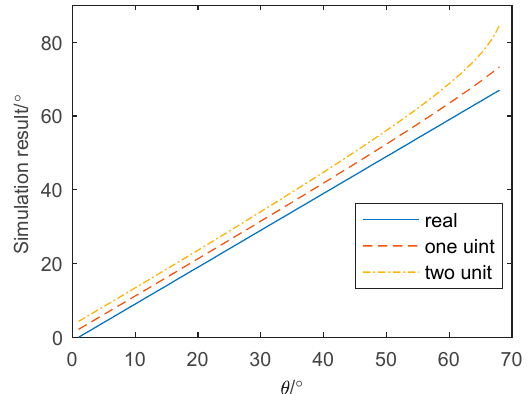
Figure 8. The 2-D imaging result of rang-elevation. It can be seen that the scatterers P 1 , P 2 and P 3 can be reconstructed accurately, but there is some error between the simulation result and actual position of the scatterer P 4 . The bandwidth of signal decides the range resolution. The range result of some scatterers may shift one range unit, thus the maximum error in range dimension by proposed method is 2-unit. Furthermore, taking scatter P 3 in Figure 8 for analysis, the range difference ∆ R between two channels is 0.2668 m in theory, and it corresponds to 8-unit in range. However, the range difference in simulation is 0.2625 m and only corresponds to 7-unit, which causes there to be about 0.007 π elevation difference between the simulation and the true value. Figure 9 shows the average calculation error is no more than 0.011 π when the elevation resolution is high enough.